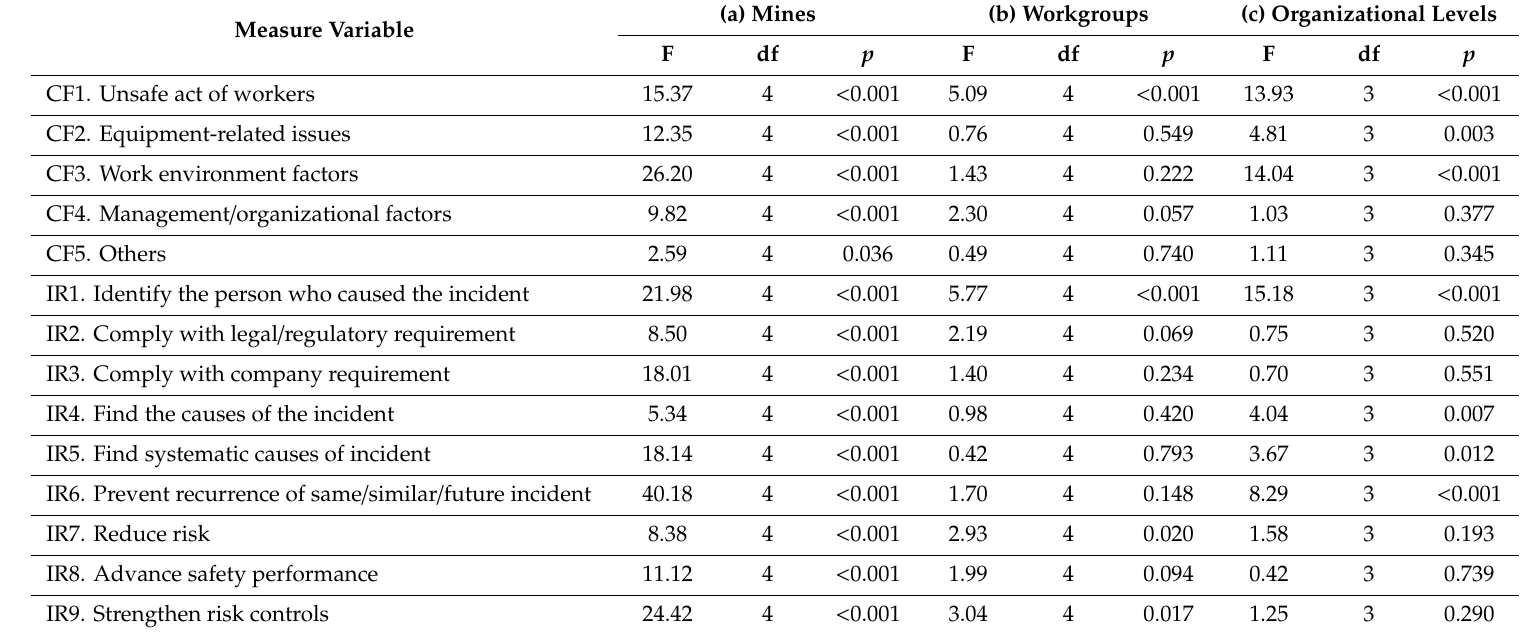
Table 3. Comparison across ( a ) mines, ( b ) work groups, ( c ) organizational level for one-way ANOVA test of the incident causal factors and reasons for investigation incidents (significant at p <